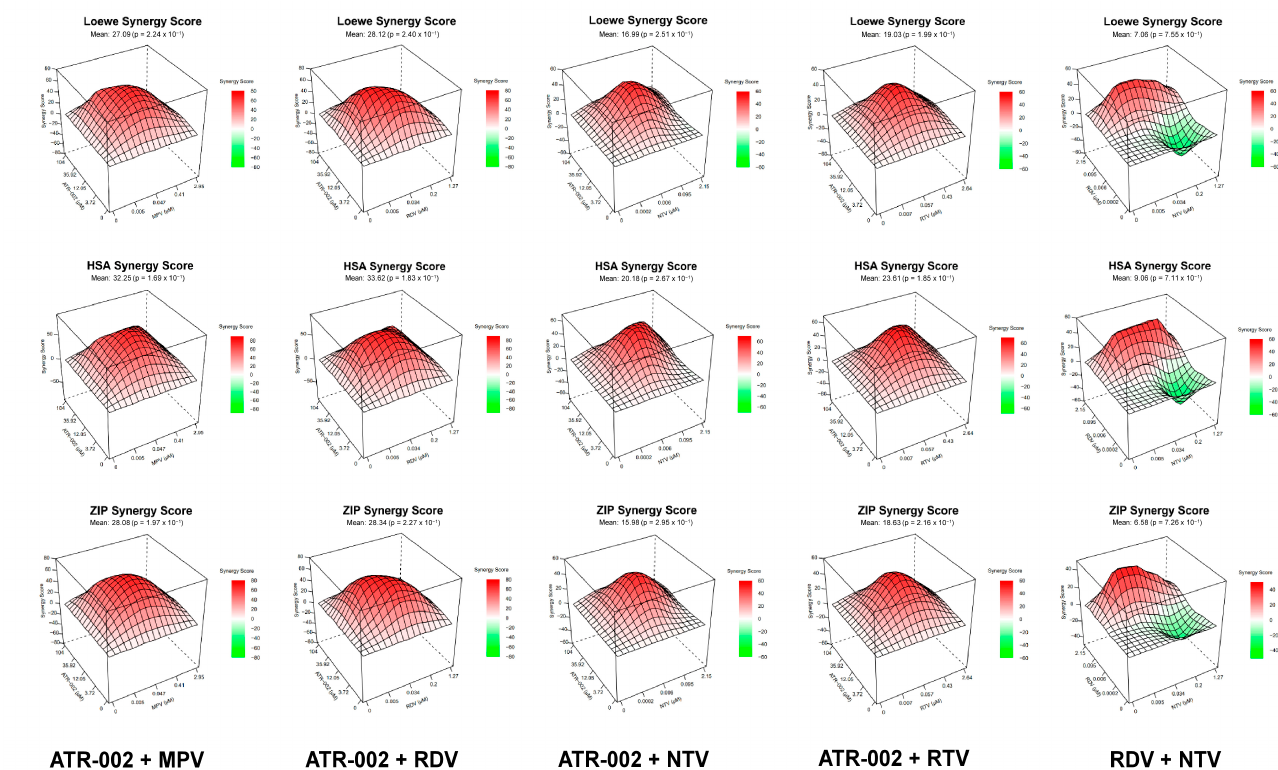
Figure 3. Synergistic evaluation of ATR-002 with DAAs in Calu-3 cells. Landscape visualization of the synergy evaluation shown in Figure 2. ATR-002 was combined with ( a ) MPV, ( b ) RDV, ( c ) NTV or ( d ) RTV. Additionally, the two DAAs, RDV and NTV, were tested in combinational treatment ( e ). Bliss independence (Bliss), Loewe additivity (Loewe), highest single agent (HSA) and Zero Interaction Potency (ZIP) reference models were used to calculate and visualize synergistic areas. Surface is color-coded. Red indicates synergistic interactions and green indicates antagonistic interactions (see also Figures S3–S7).